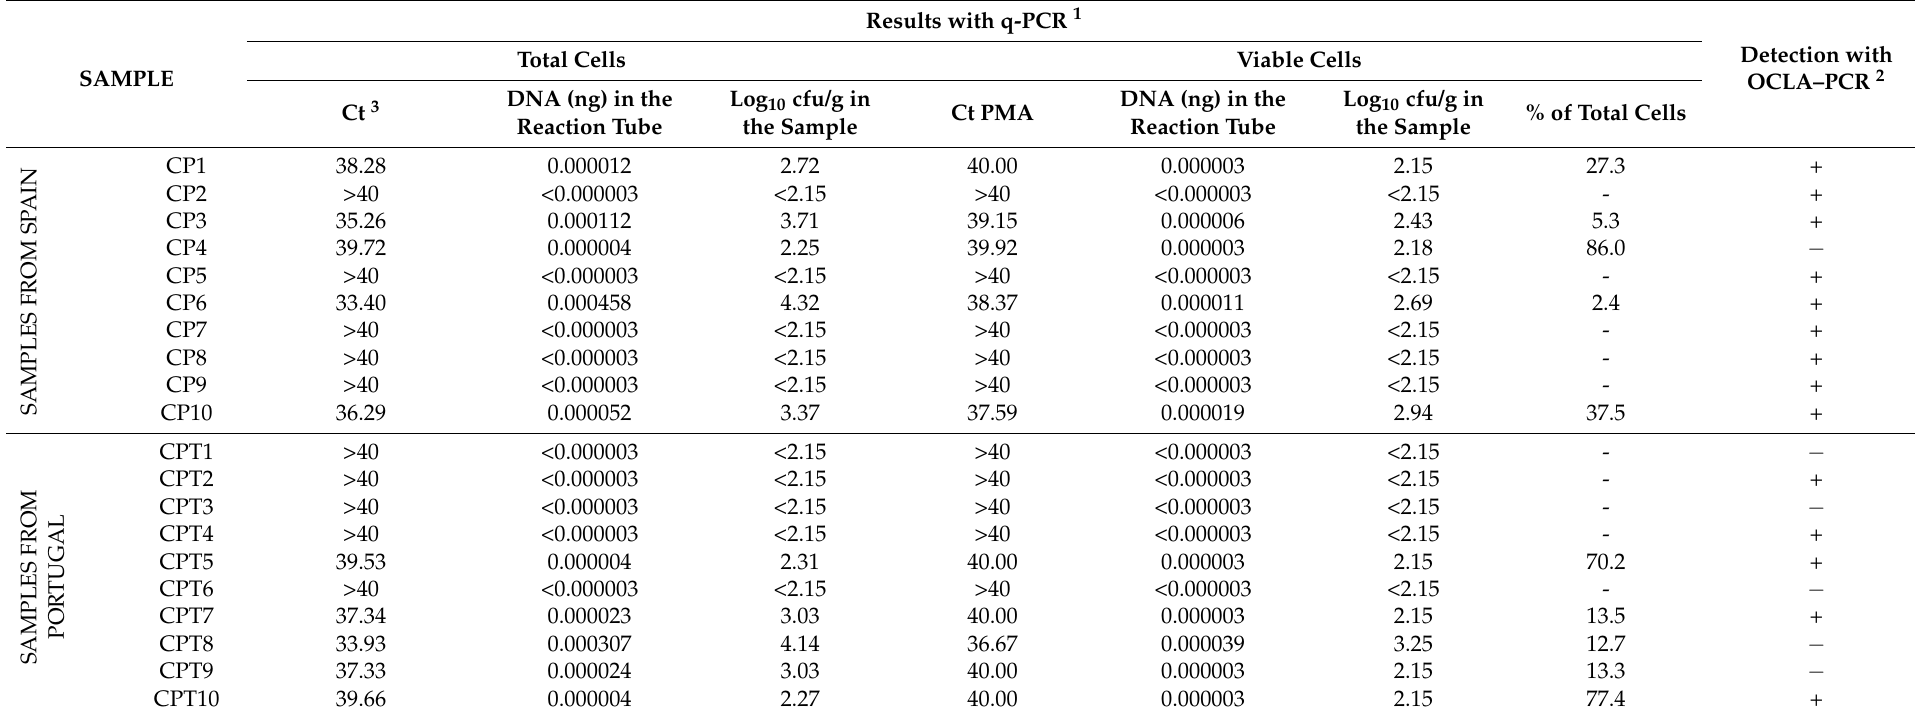
Table 2. The transformed results of the quantification of Listeria monocytogenes in samples of minced chicken by